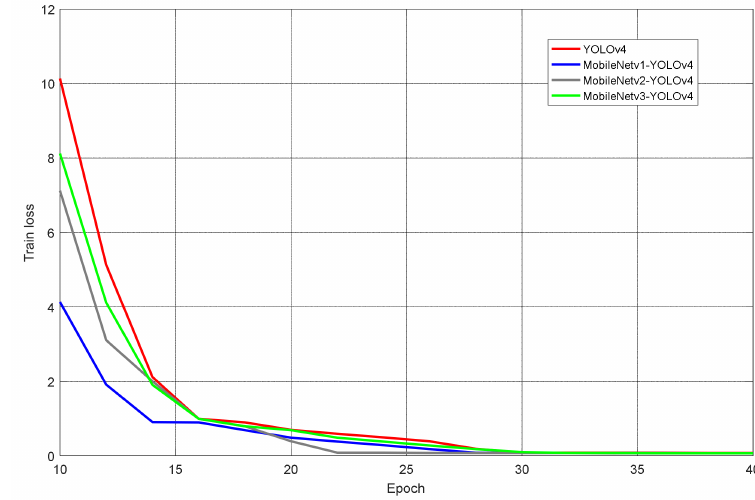
Figure 11. Detailed loss value between epoch 10 and 40.